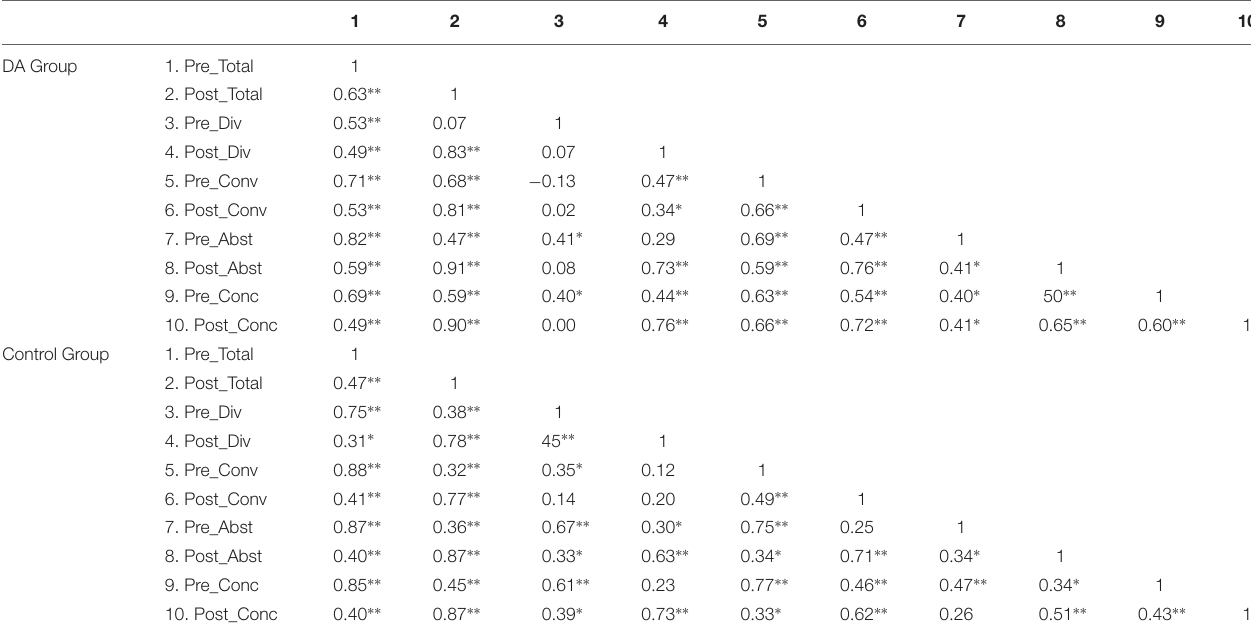
TABLE 3 | Correlations in pre- and post-test EPoC scores by